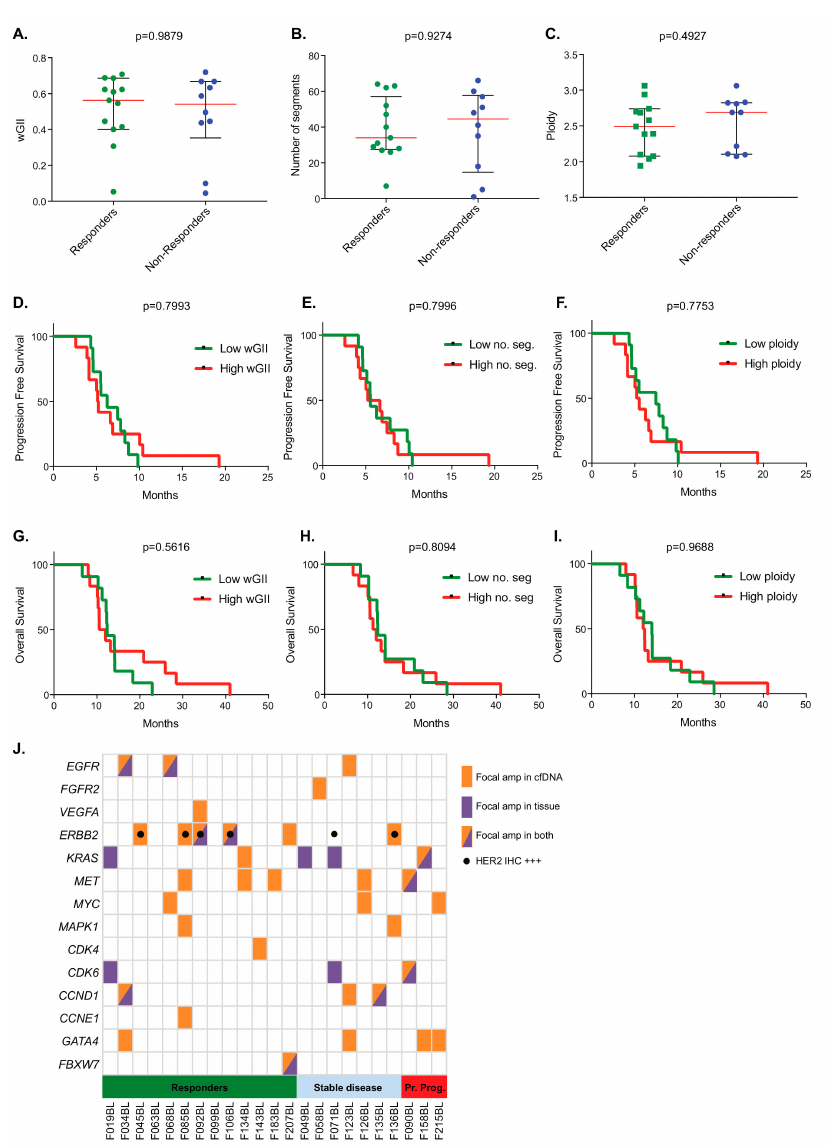
Figure 3. ( A ) Association of pretreatment chromosomal instability (CIN) metrics with subsequent treatment response by comparing analysis of genomic change relative to ploidy using weighted genomic instability index (wGII), ( B ) nonploidy segment number, and ( C ) ploidy between responder and nonresponder groups (line denotes median and interquartile range; p -value Mann–Whitney test). ( D ) Kaplan–Meier progression free survival analyses grouping by high / low wGII, ( E ) nonploidy segment number, and ( F ) ploidy. ( G ) Kaplan–Meier overall survival analyses grouping by high / low wGII, ( H ) nonploidy segment number, and ( I ) ploidy. ( J ) Heatmap showing focal gene amplifications (50 kb bins) detected by cfDNA lcWGS at pretreatment (orange) or by archival target sequencing (purple) in each case. Black dots indicate cases classed as HER2 + by immunohistochemistry. Green = responder group, blue = stable group, and red = primary progressor